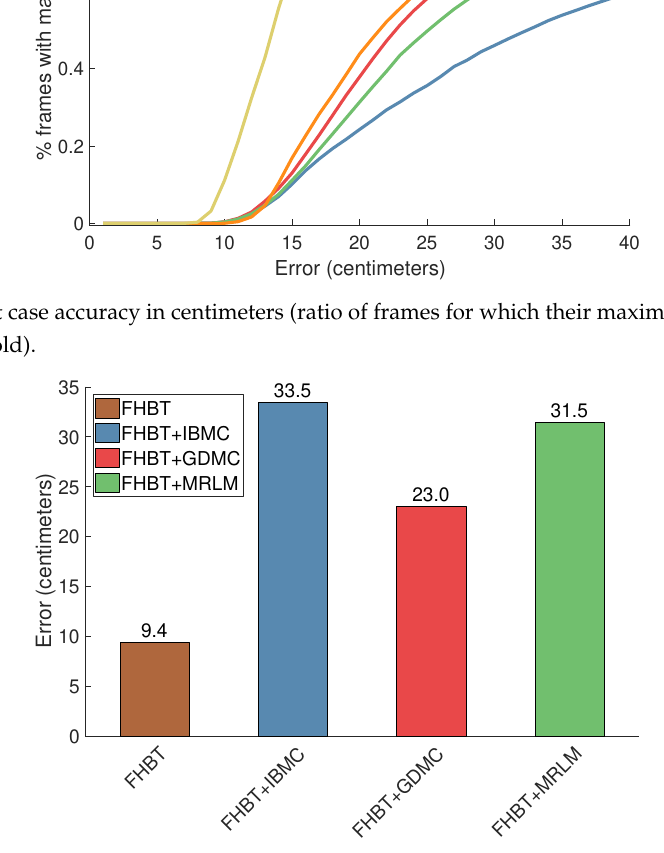
Figure 12. Same as Figure 9 but taking into account only the error of estimated/completed joints,